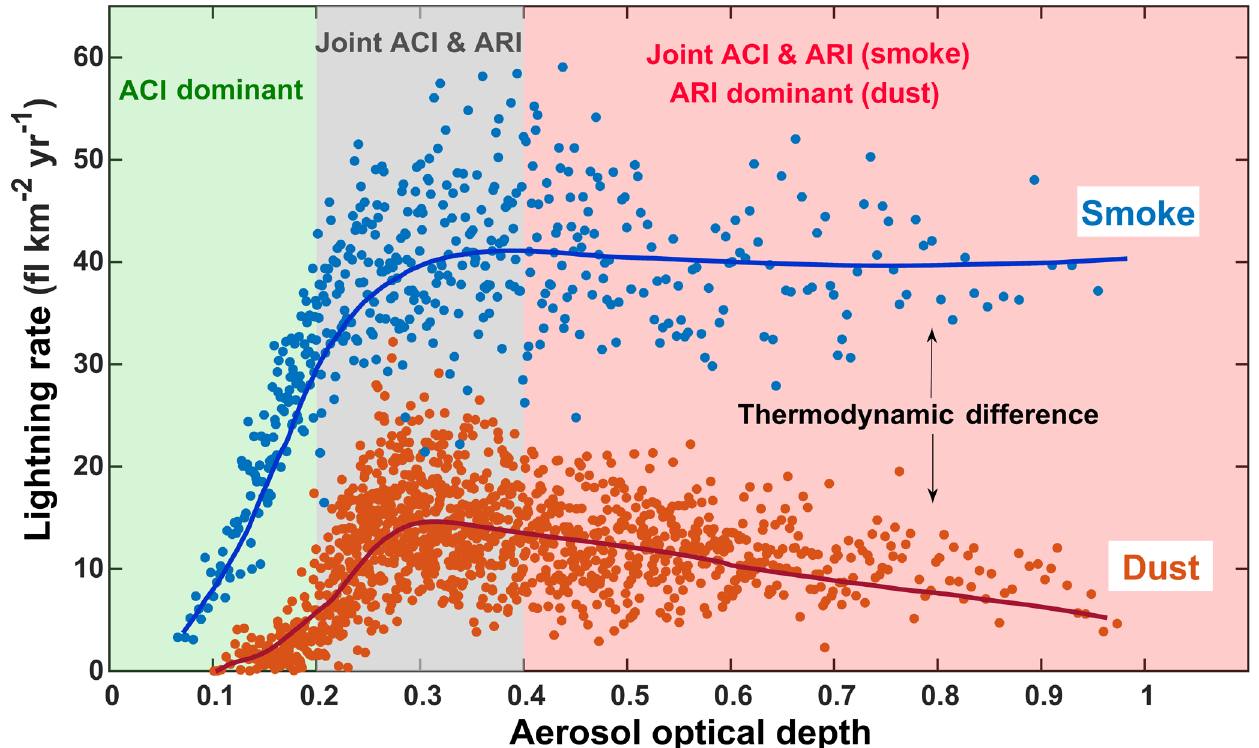
Figure 9. Lightning flash rate as a function of aerosol optical depth (AOD) in the dust- (orange points) and smoke-dominant regions (blue points). Note that all data pairs (i.e., a 3-month mean lightning rate and a 3-month mean AOD) are first ordered by AOD from small to large. Mean values of both AOD and lightning flash rate in each 10-sample bin are then calculated to reduce the uncertainty caused by the large dispersion of data. The two curves are created by applying a 100-point moving average (50-point) thrice to the mean values of lightning flash rate in each 30-sample bin for the dust-dominant (smoke-dominant) region. Note that data used here are for the entire AOD range but only shown for the range AOD ∈ (0, 1). Turning points in the boomerang shapes are around AOD = 0.3. Aerosol–cloud interactions (ACI) play a dominant role in lightning activity under relatively clean conditions (green zone). As AOD exceeds 0.3, both ACI and aerosol–radiation interaction (ARI) effects come into play with different magnitudes. For dust aerosols, ACI and ARI have the same effect of suppressing convection in the dry environment favorable for evaporating cloud droplets. The moist environment of central Africa strengthens aerosol invigoration that offsets the suppression due to ARI, leading to a nearly flat line in the grey and red